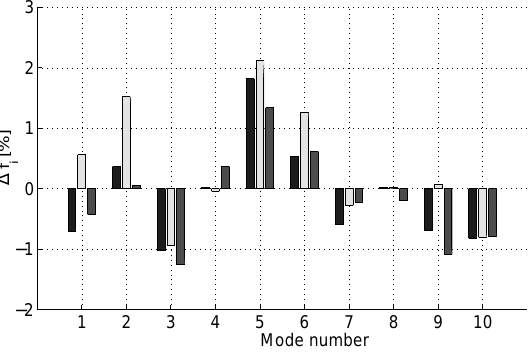
Fig. 8. Frequency deviation of the updated model: R&A dark gray, R&AV light gray, R&MAC medium